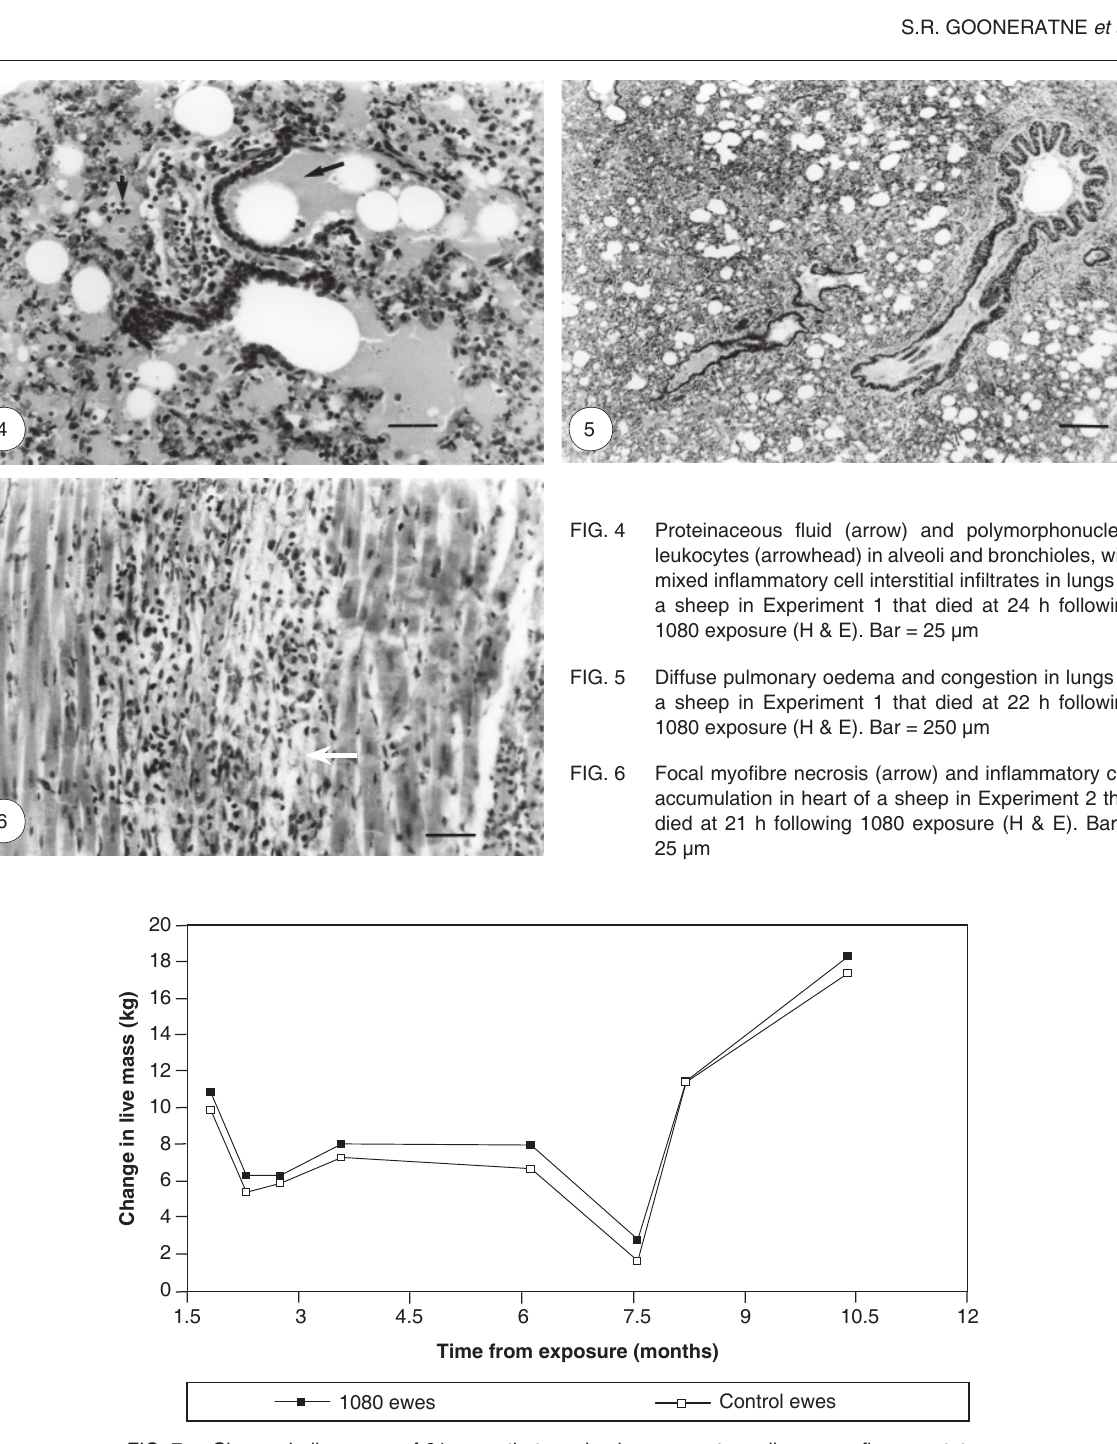
of 1080-exposed ewes in the first (5.63 ± 0.2 kg) and second (4.5 ± 0.1 kg) years after dosing was not significantly different from that of the control sheep (5.54 ± 0.1 kg; P = 0.67 and 4.37 ± 0.1 kg; P = 0.37, respectively).